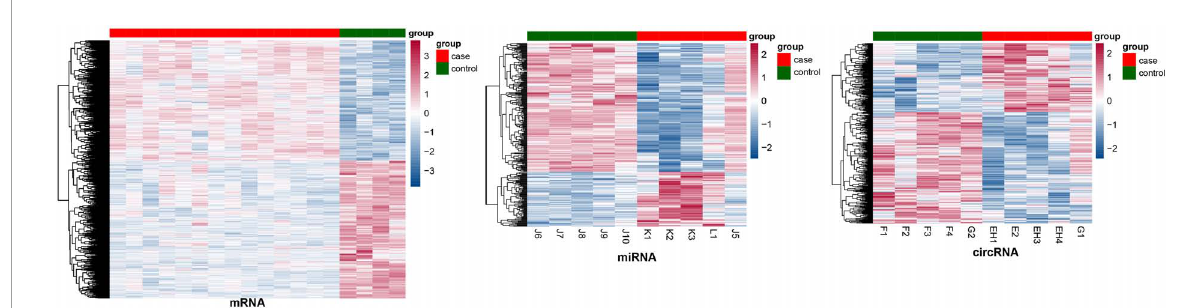
FIGURE2 The heatmaps of differentially expressed mRNAs, miRNAs, and circRNAs.